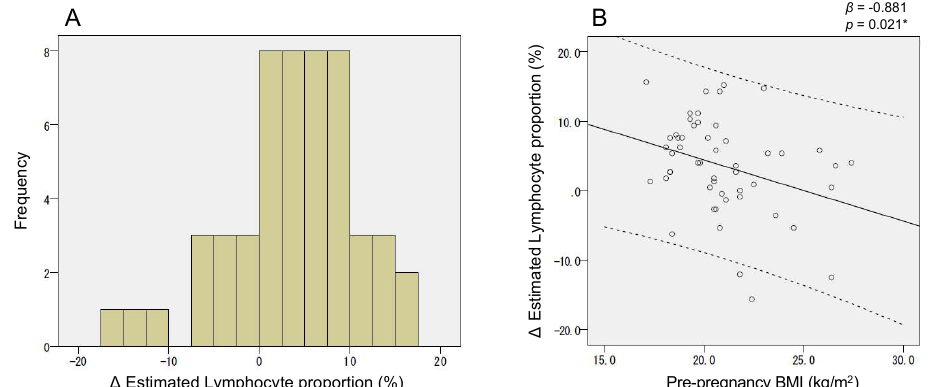
Figure 5. Intra-individual lymphocyte proportion change during mid-to-late gestation was associated with pre-pregnancy BMI. ( A ) Histogram of estimated lymphocyte proportion change (∆ lymphocyte proportion) (%). ( B ) Association between pre-pregnancy BMI and estimated lymphocyte proportion change (∆ lymphocyte proportion).